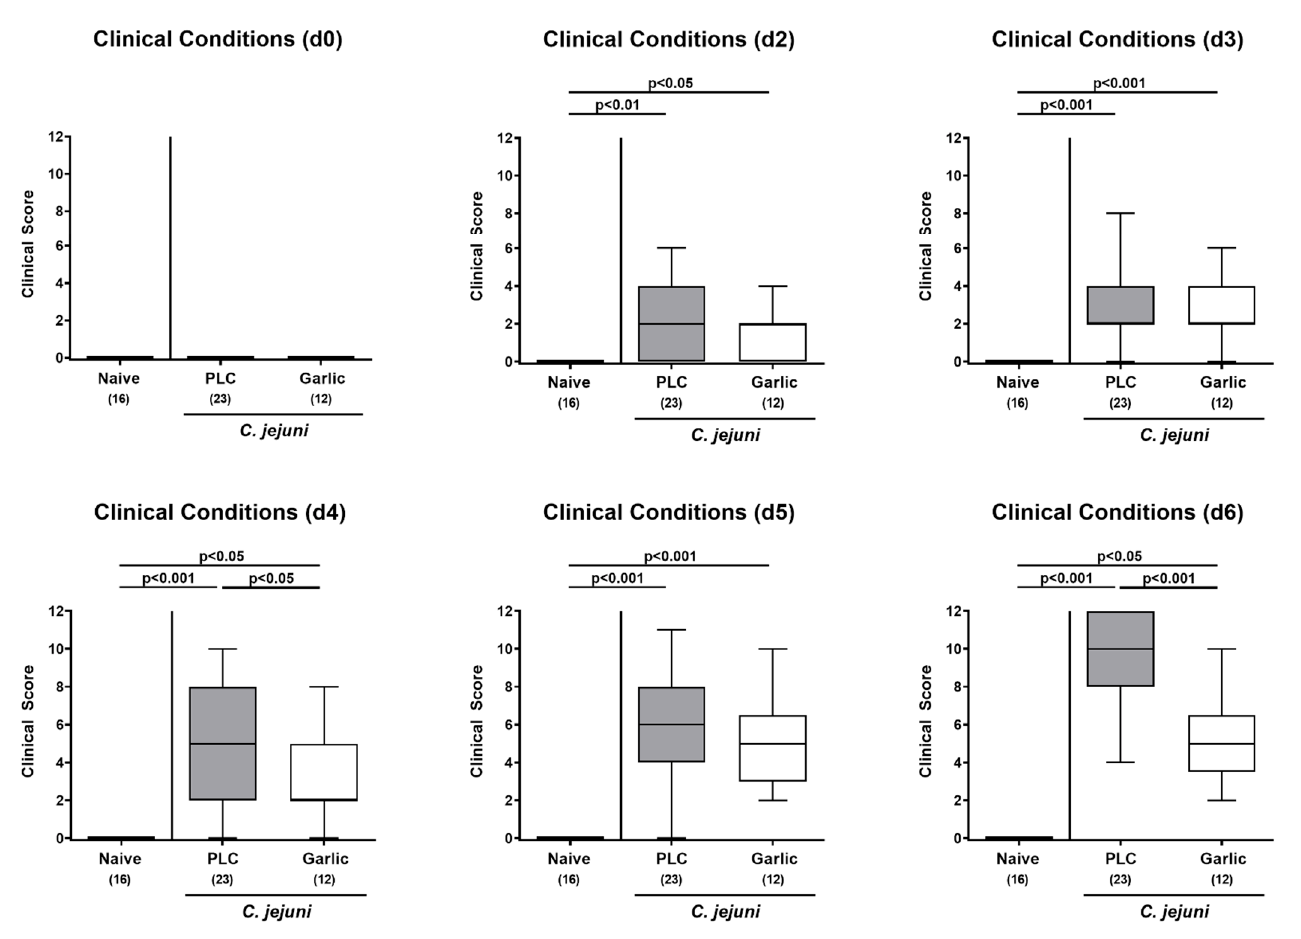
Figure 2. Time course of clinical conditions upon garlic essential oil treatment of C. jejuni infected IL-10 -/- mice. Secondary abiotic IL-10 -/- mice were orally challenged with C. jejuni strain 81-176 on day (d) 0 and d1 followed by treatment with either garlic essential oil (white boxes) or placebo (PLC, gray boxes) via the drinking water starting on d2 post-infection. The clinical conditions of mice were quantitated by using distinct clinical scores (see methods). Naive mice (hatched boxes) served as non-infected and untreated cohort. Box plots (indicating the 25th and the 75th percentiles), whiskers (indicating maximum and minimum values), medians (black bar inside box), significance levels ( p values) determined by the Kruskal-Wallis test and Dunn’s post-correction and the number of analyzed animals (in parentheses) are shown (pooled data from four independent experiments).